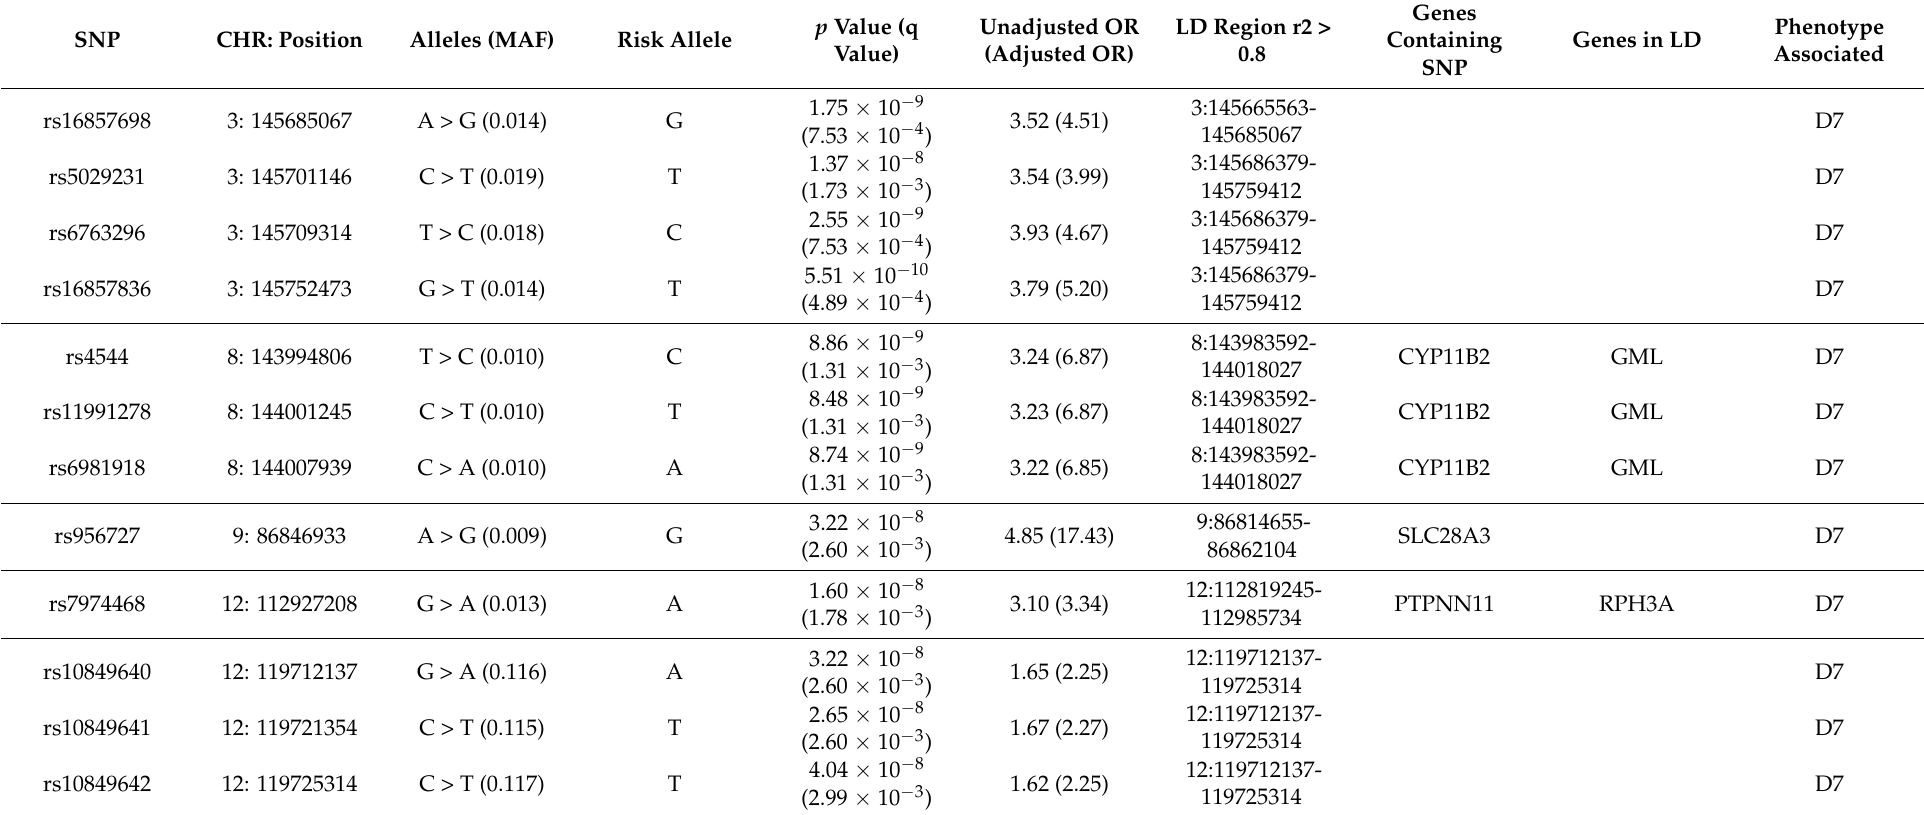
Table 1. Loci associated with the mortality due to sepsis at day 7 or at day